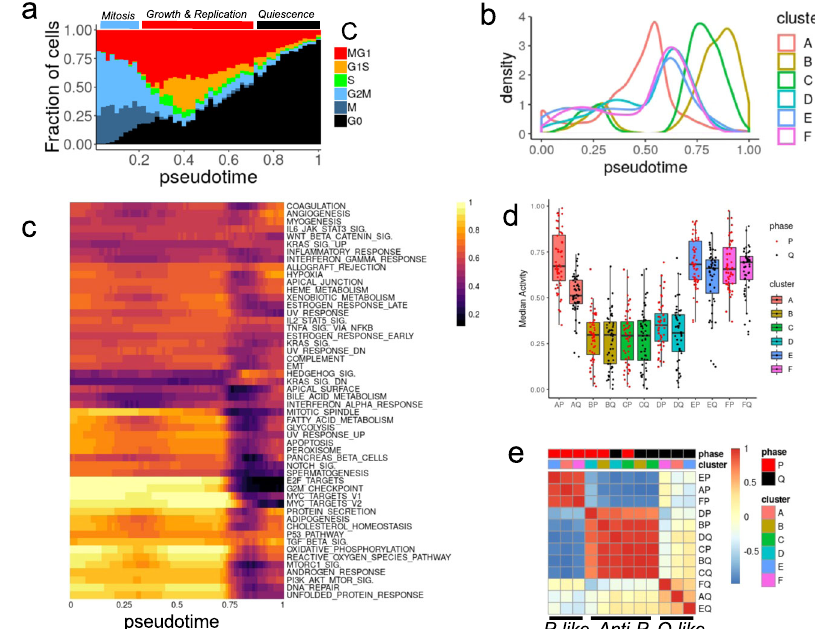
Fig. 4 Functional analyses of single-cell resistant states after in silico synchronization. a Fraction of cells in each inferred cell cycle phase as a function of the pseudo-time ( x axis bins). Three aggregated cell cycle phases are indicated above the plot and determined by bins containing more than 50% of the cells in G2/M or M (mitosis, blue bar, pt < 0.2), in G1S or MG1 (growth and proliferation, red bar, 0.2 ≤ pt < 0.69) or in G0 (quiescence, black bar pt ≥ 0.69) . b The distribution of cells (kernel density – y axis) along the pseudo-time trajectory ( x axis) is represented for each expression-based clustering. c Scaled enrichment score (ES) of the hallmark gene sets (clustered rows) observed in cluster A cells as a function of pseudo-time (columns). d Median scaled enrichment score of all hallmark gene sets across cells from P (red points) and Q (black points) phases for each of the 6 clusters. Boxes represent the top and bottom quartiles of the distribution and whiskers are extended to 1.5 time the interquartile range. e Correlation of hallmark gene sets median scaled enrichment score for all clusters and proliferation